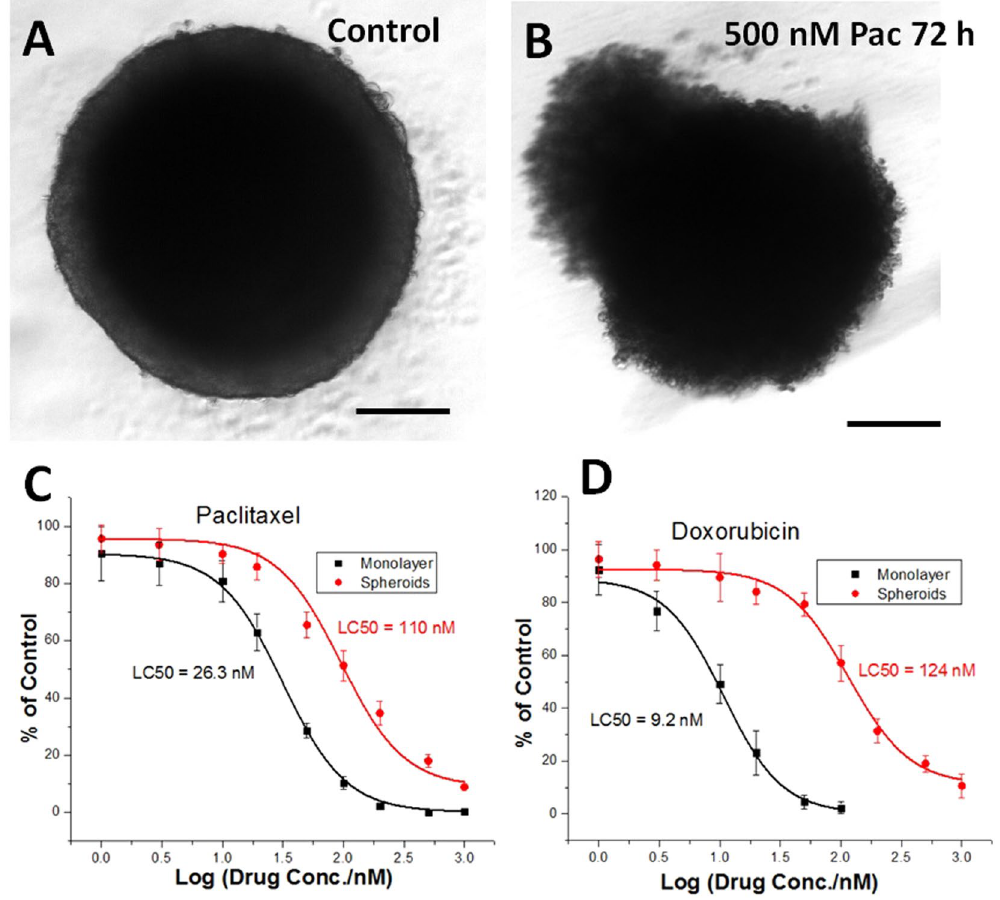
Figure 6. The drug effect on HCT116 tumor spheroids by APH assay. Similar size spheroids (diameter ~500 µ m) were treated with different concentrations of Paclitaxel and Doxorubicin for 72 h, and ( A ) shows a typical controlled spheroid, while ( B ) shows a spheroid that was treated by 500 nM Paclitaxel for 72 h. More detailed images can be found in Fig. S10. Drug effects of Paclitaxel ( C ) and Doxorubicin ( D ) in spheroids cultures, with comparison to monolayer cell cultures. Dose-response curves were plotted exponentially. Scale bars = 200 µ